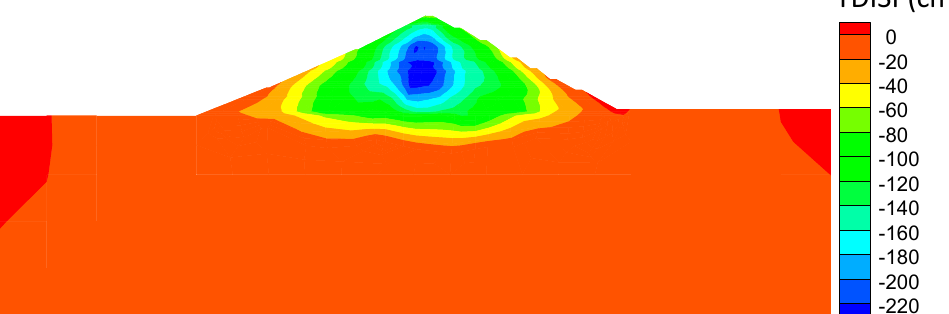
Figure 9. The contour of settlement displacement of the dam when the reservoir level first reaches the normal water level.